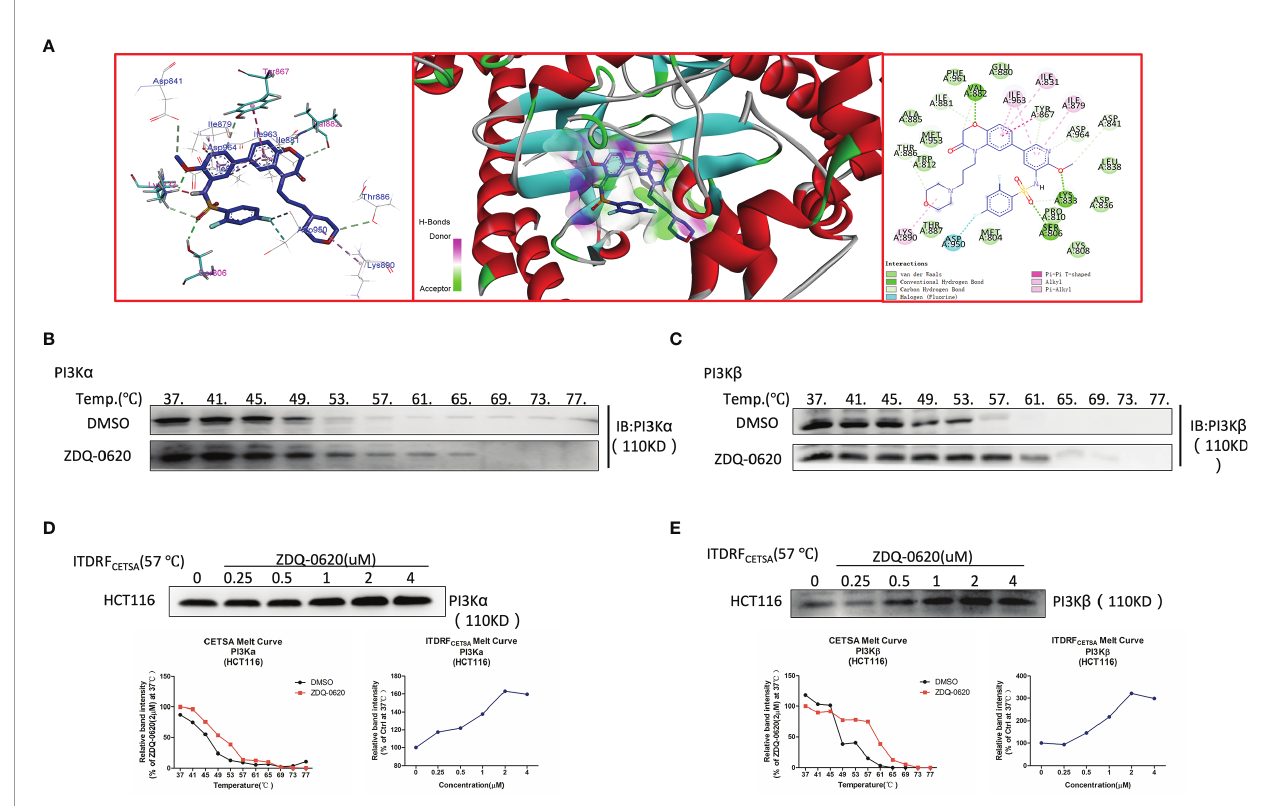
FIGURE 5 | ZDQ-0620 inhibits PI3K target activity. (A) Predicted binding modes for ZDQ-0620 with PI3K a (PDB code: 4JPS). (B – E) A cellular thermal shift assay (CETSA) and an isothermal dose-response fi ngerprinting (ITDRF)cetsa were used to evaluate the thermal stability of ZDQ-0620 bound to PI3K a / b .